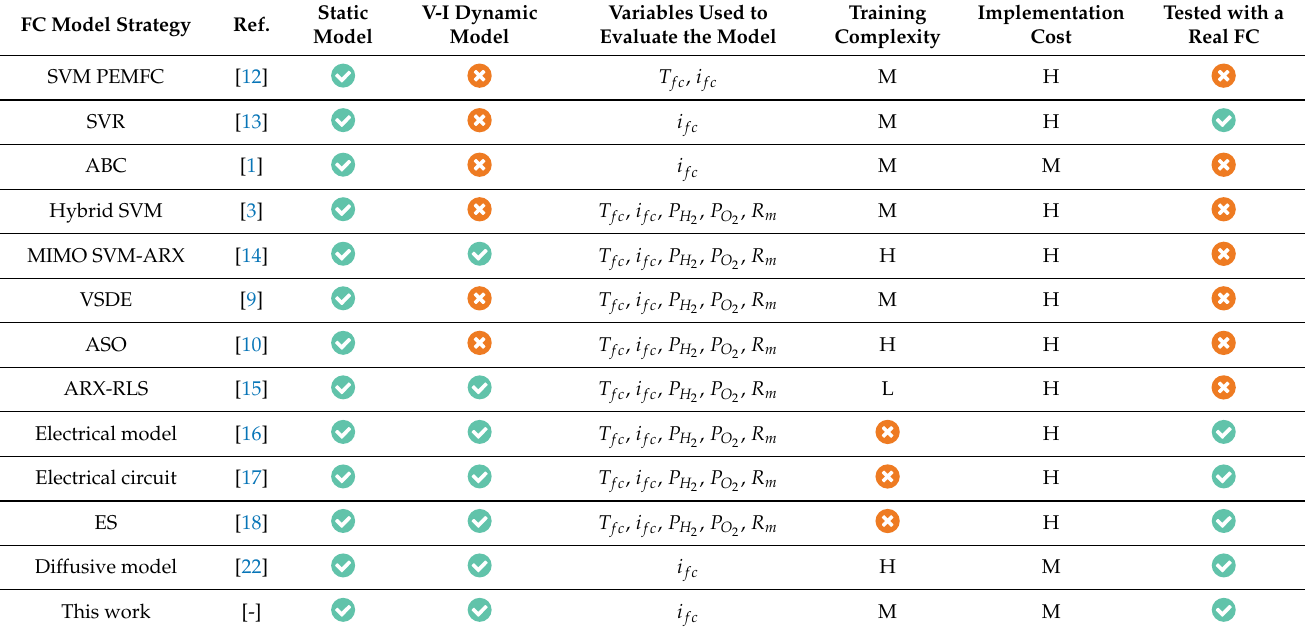
Table 1. Fuel cell intelligence model